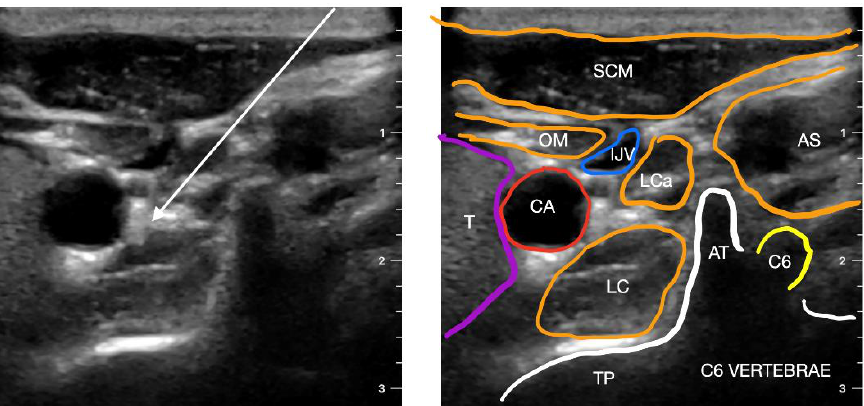
Figure 4. Transverse sonogram of the posterior neck area at the C6 level. The arrow indicates the needle trajectories for stellate ganglion block. SCM—sternocleidomastoid muscle; OM—omohyoid muscle; T—thyroid gland; CA—carotid artery; IJV— internal jugular vein; LC—longus colli muscle; LCa—longus capitis muscle; AS—anterior scalene muscle; TP—transverse process; AT—anterior tubercle of the transverse process; C6—C6 nerve root.